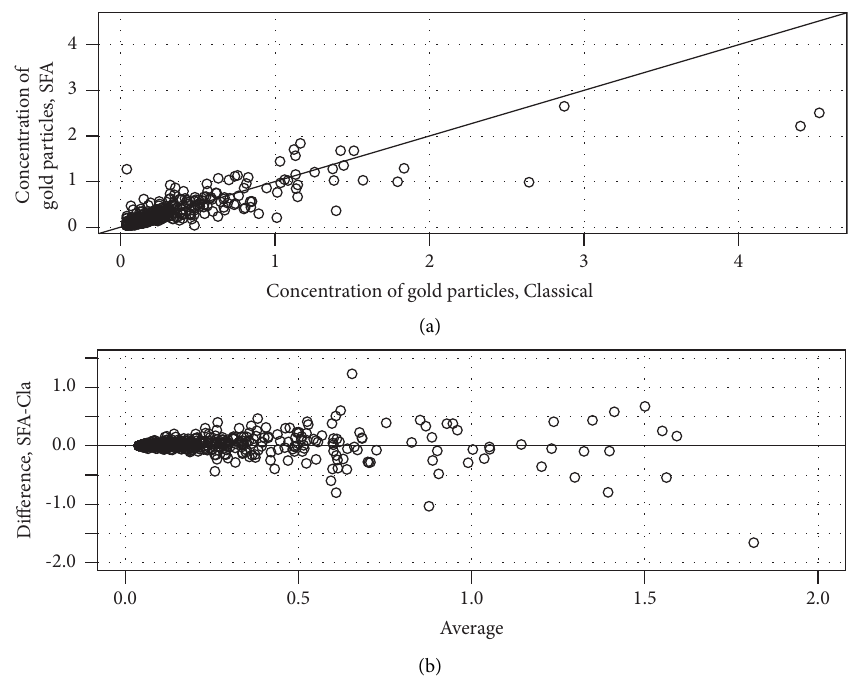
Figure 3: (a) A scatter plot with a line of equality and (b) Bland–Altman plot with zero line for gold particle